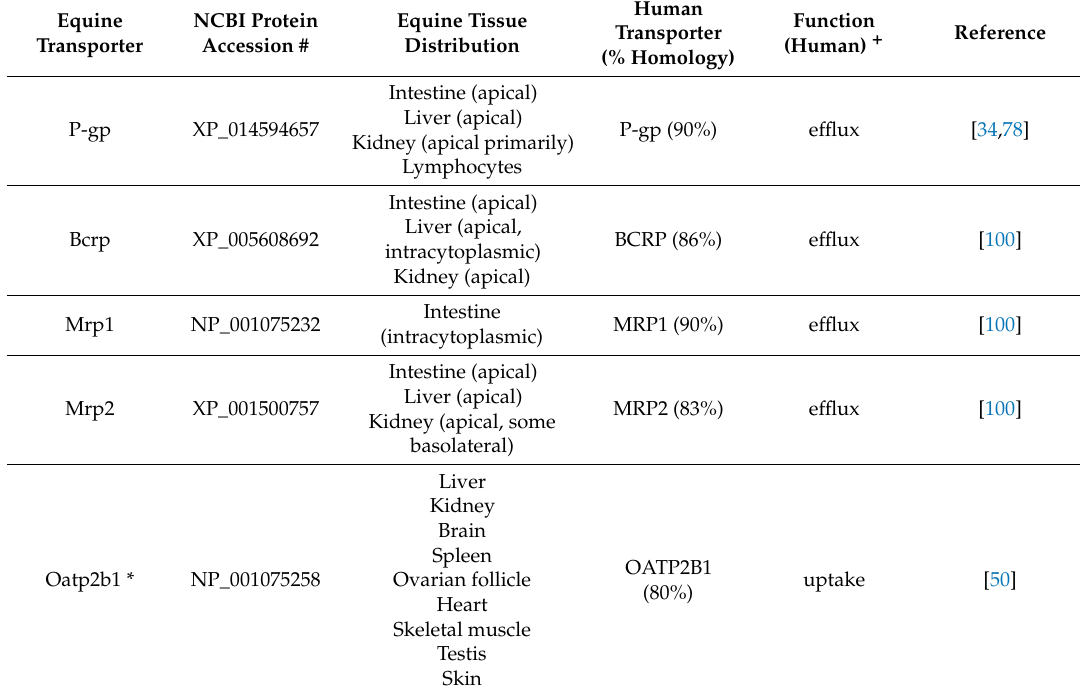
Table 1. Drug transport proteins that have been experimentally identified in horses. P-gp = permeability glycoprotein ( Abcb1 ); Bcrp = breast cancer resistance protein ( Abcg2 ); Mrp1 = multidrug resistance protein 1 ( Abcc1) ; Mrp2 = multidrug resistance protein 2 ( Abcc2 ); Oatp2b1 = organic anion transporting polypeptide 2b1 ( Slco2b1 ). * Identified by mRNA expression only (all others were by protein